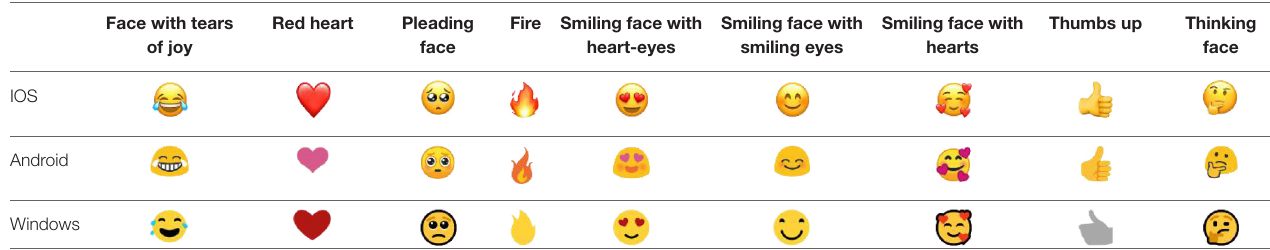
TABLE 4 | Emoji differences on major